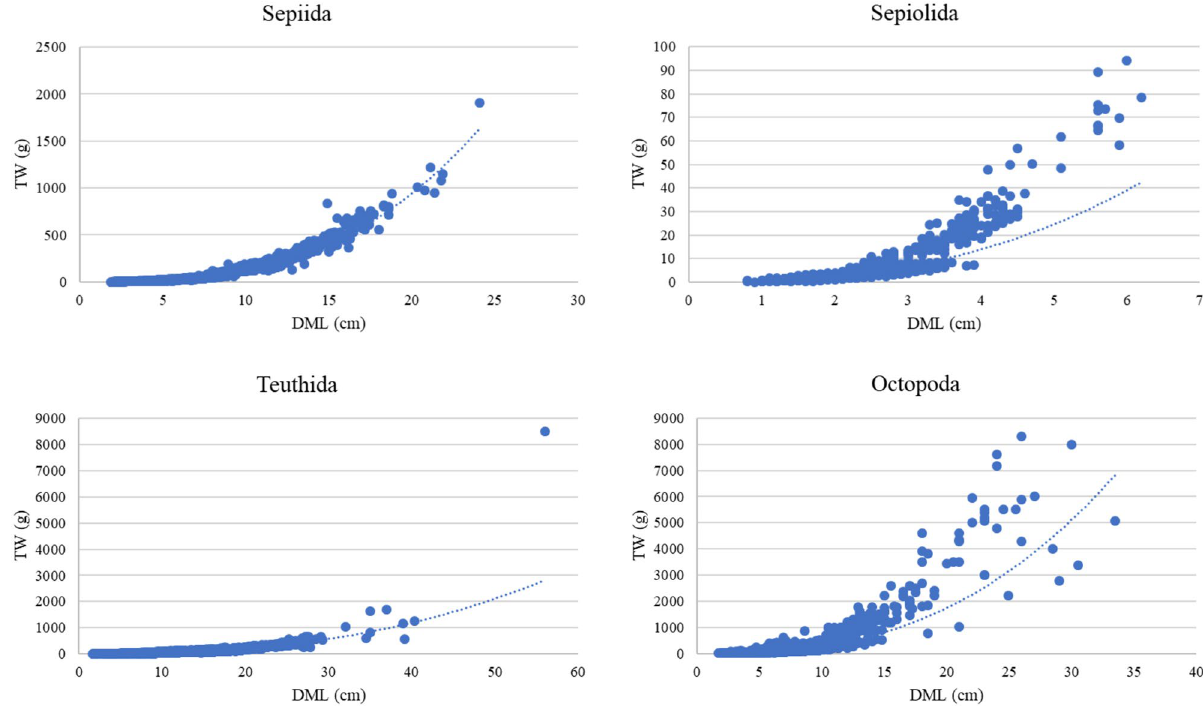
Figure 1. Length–weight distribution of cephalopods by orders ( TW total weight in grams, DML dorsal mantle length in